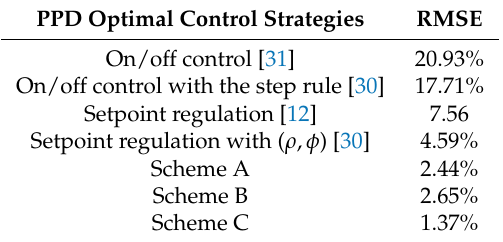
Figure 11. Power tracking results under Scheme A, Scheme B, and Scheme C. ( a ) Power tracking results under Scheme A when N = 800. ( b ) Power tracking results under Scheme B when N = 800. ( c ) Power tracking results under Scheme C when N = 800. Table 4. Comparison between different control